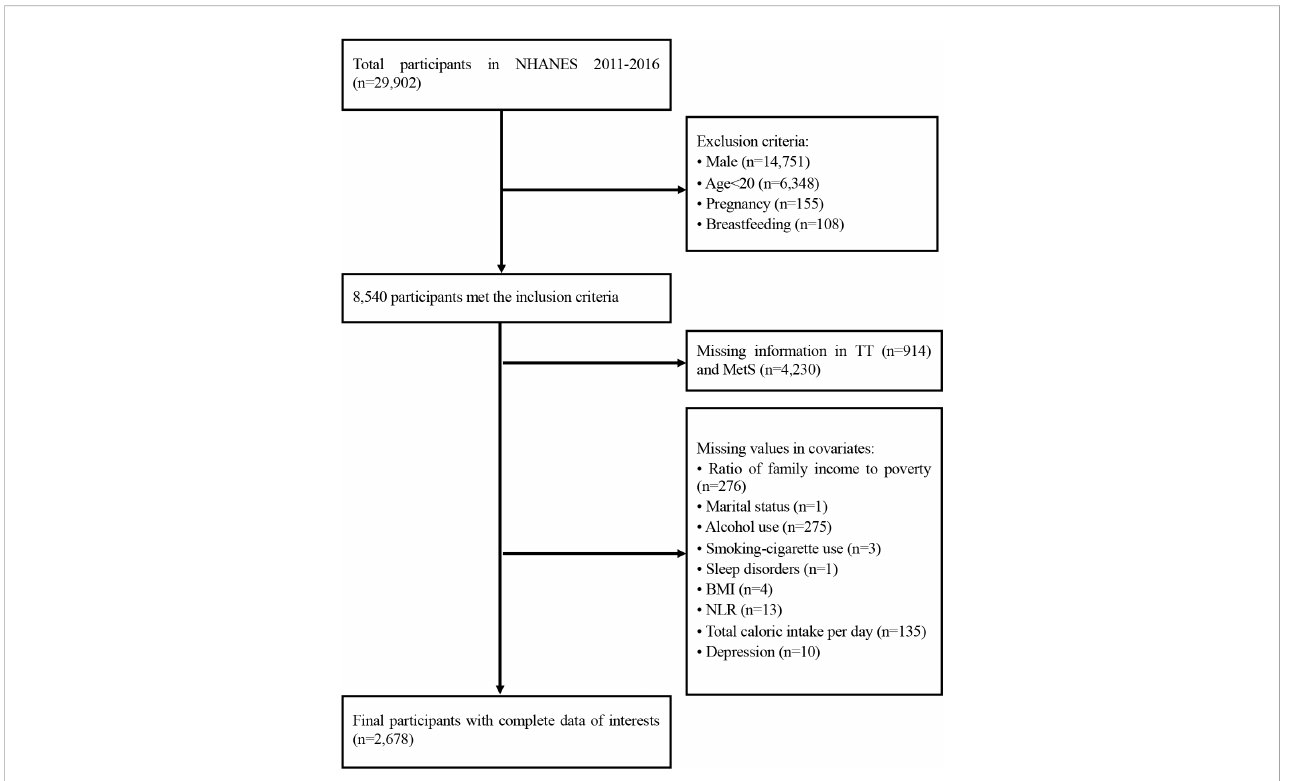
FIGURE 1 Flowchart of the study design. TT, total serum testosterone level; MetS, metabolic syndrome; BMI, body mass index; NLR, neutrophil-to-lymphocyte